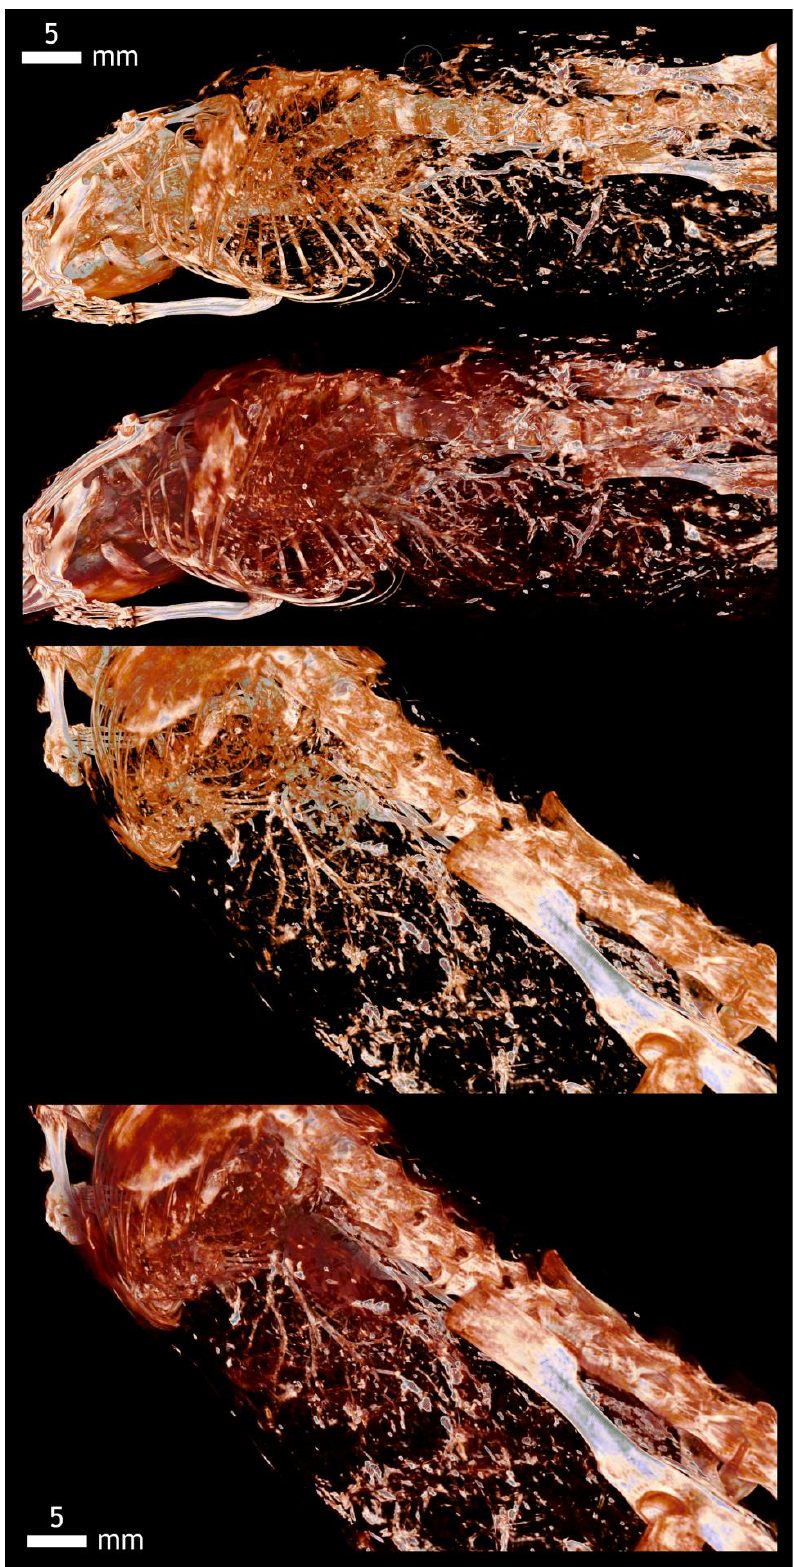
Figure A7. Transition of the thoracic and abdominal cavities and vascular supply of the lungs, heart, and the vessels of the liver and intestine. Simultaneous imaging of the bronchial ventilated tree helps to differentiate individual vascular systems. Detail of the hepatic vessels shows their segmentation into individual lobes. Another vascular system in the abdominal cavity corresponds to the largest perfusion in the bloodstream of the small and large intestine.